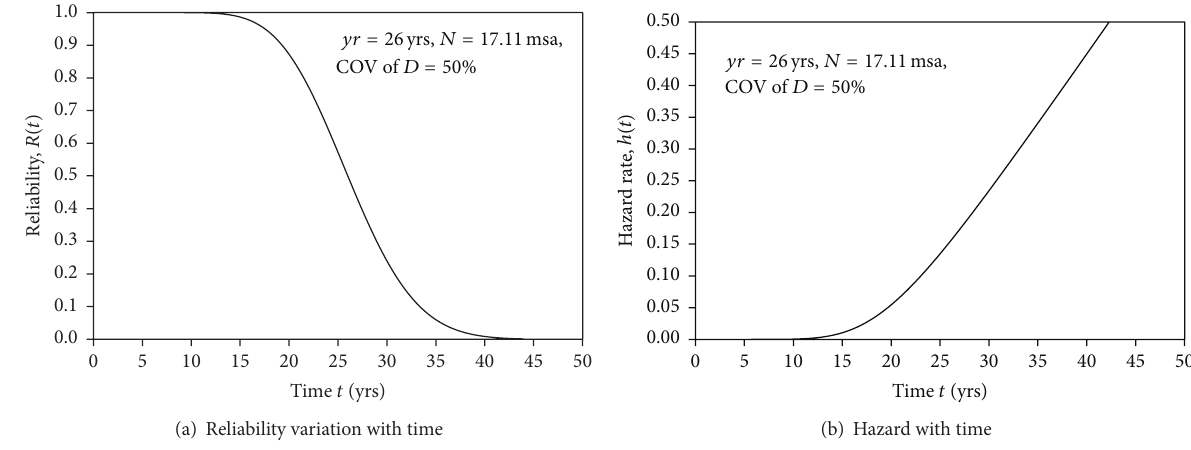
Figure 1: Reliability and hazard as a function of